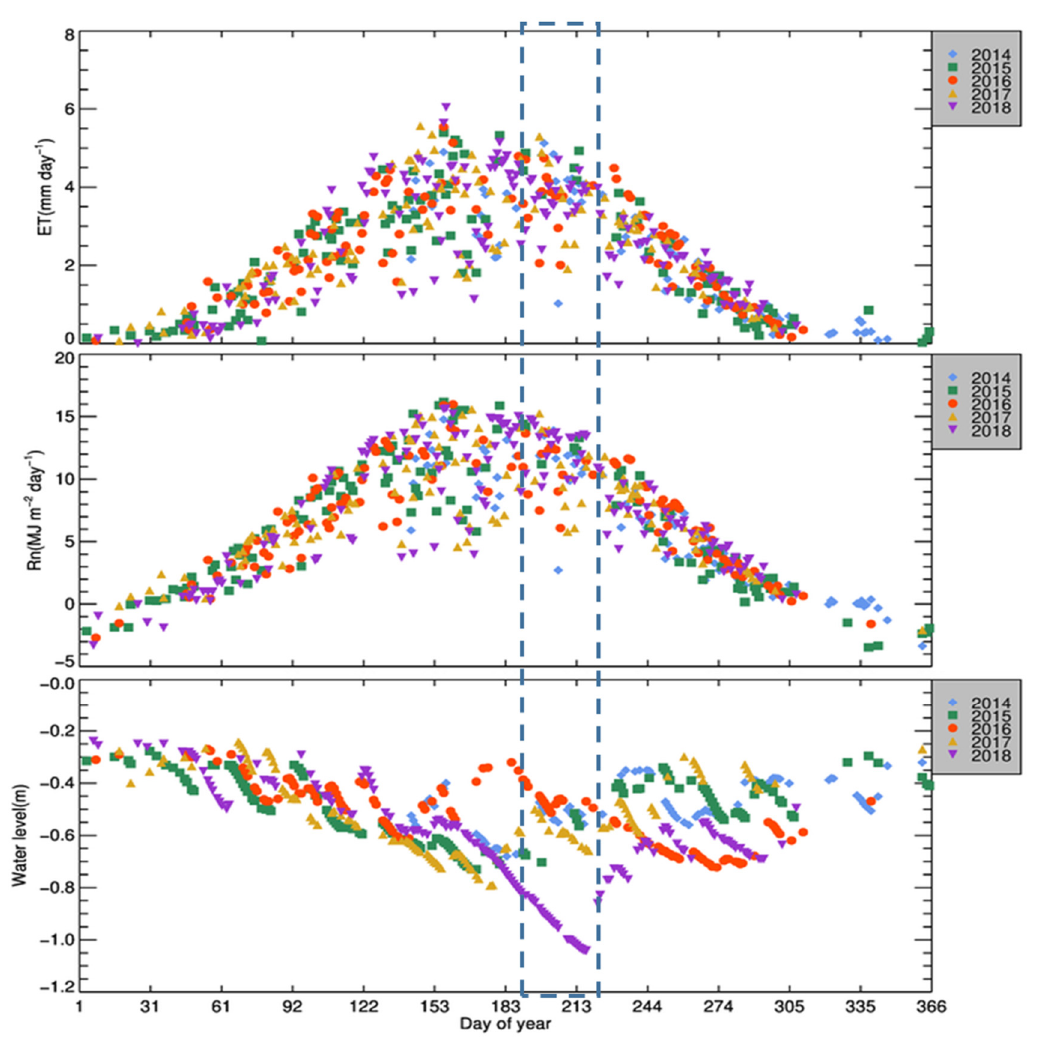
Figure 9. The progression of daily ET and corresponding measured net radiation flux and water table (under ground level) during June 2014 to Oct 2018.